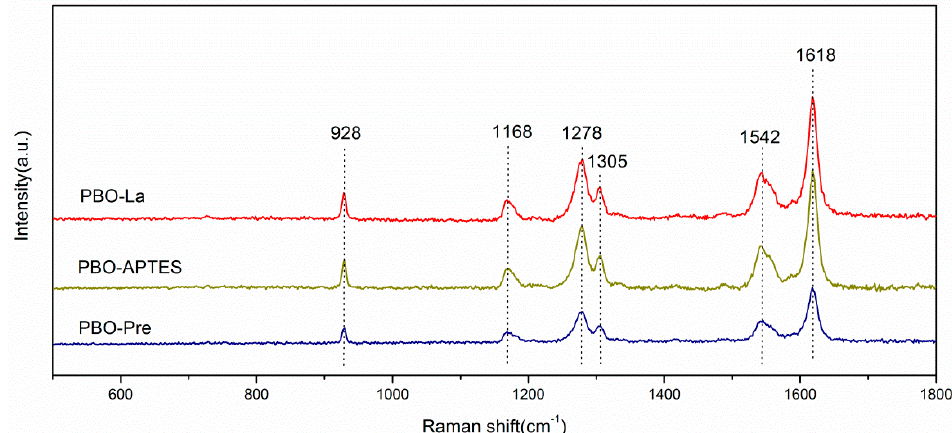
Figure 6. Raman spectra of PBO-Pre, PBO-APTES and PBO-La fibers.